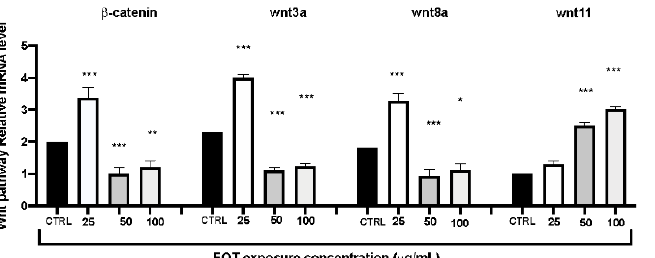
Figure 5. The fotemustine exposure effects on Wnt pathway related genes on zebrafish embryos. The results are expressed as mean of three independent experiment data. The expression levels of mRNA are represented as the fold change from the CTRL group. * p < 0.05, ** p < 0.01, *** p < 0.001 versus CTRL.